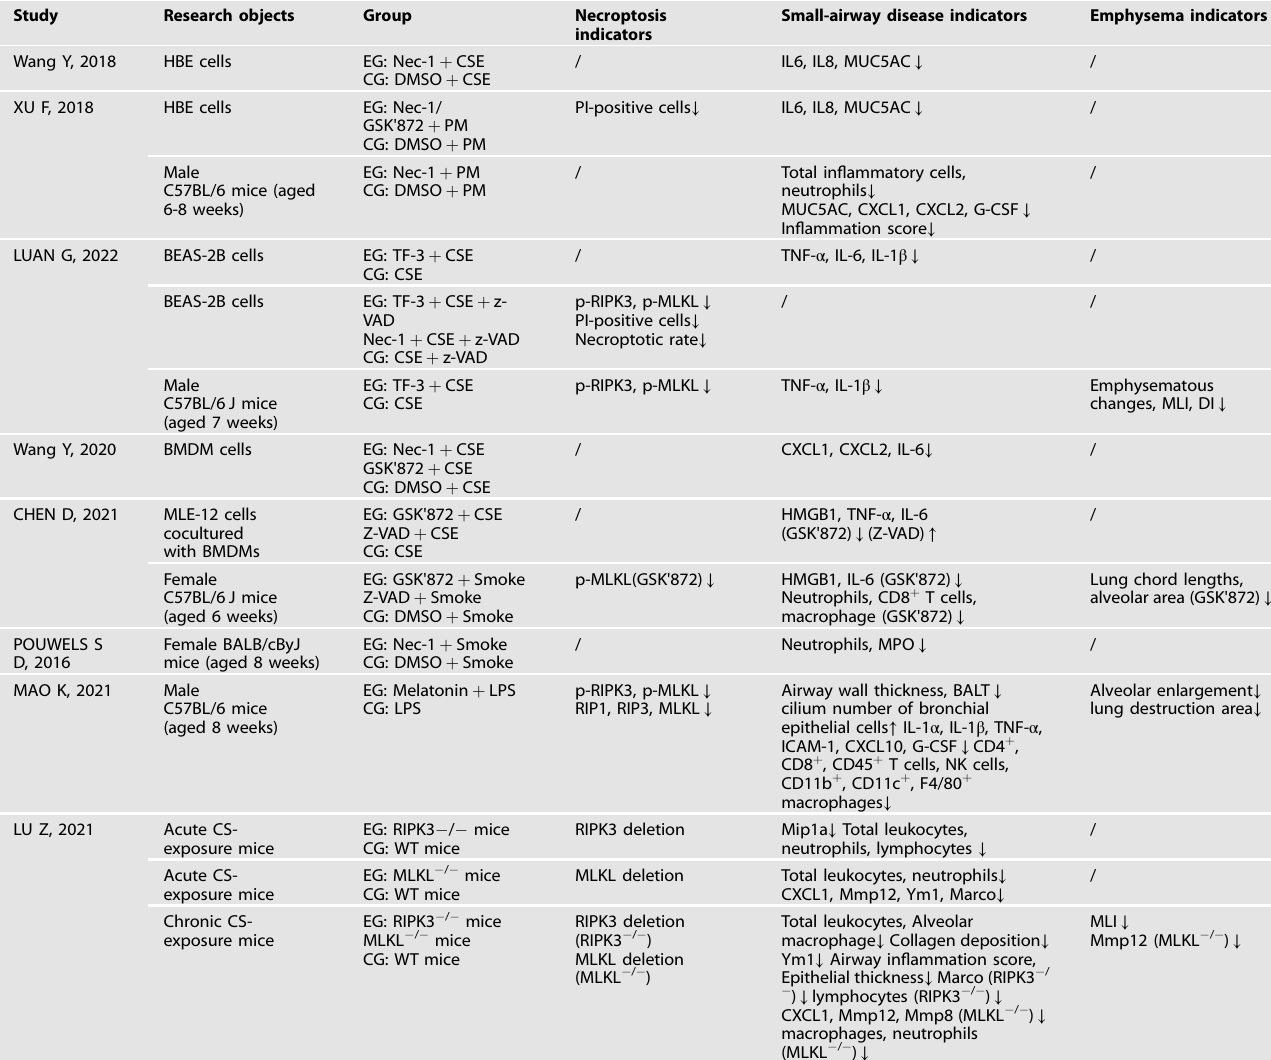
Table 1. The role of necroptosis in small-airway disease and